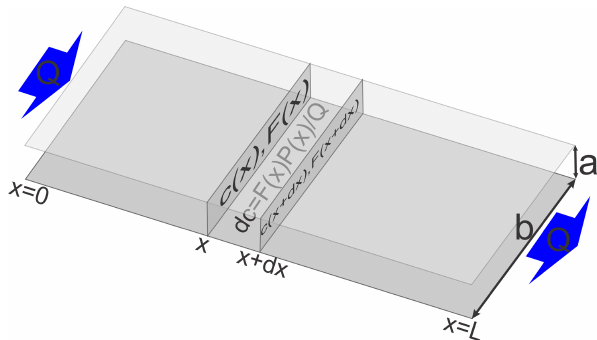
Figure 2. Discretization and mass conservation in a basic network element; a 1-D fracture. The conservation of mass requires that the change in concentration d c in the section between x and x + d x is proportional to its surface P(x) d x , where P(x) is the perimeter. The change in concentration d c is also proportional to the dissolution rates F(x) and inversely proportional to the flow rate Q